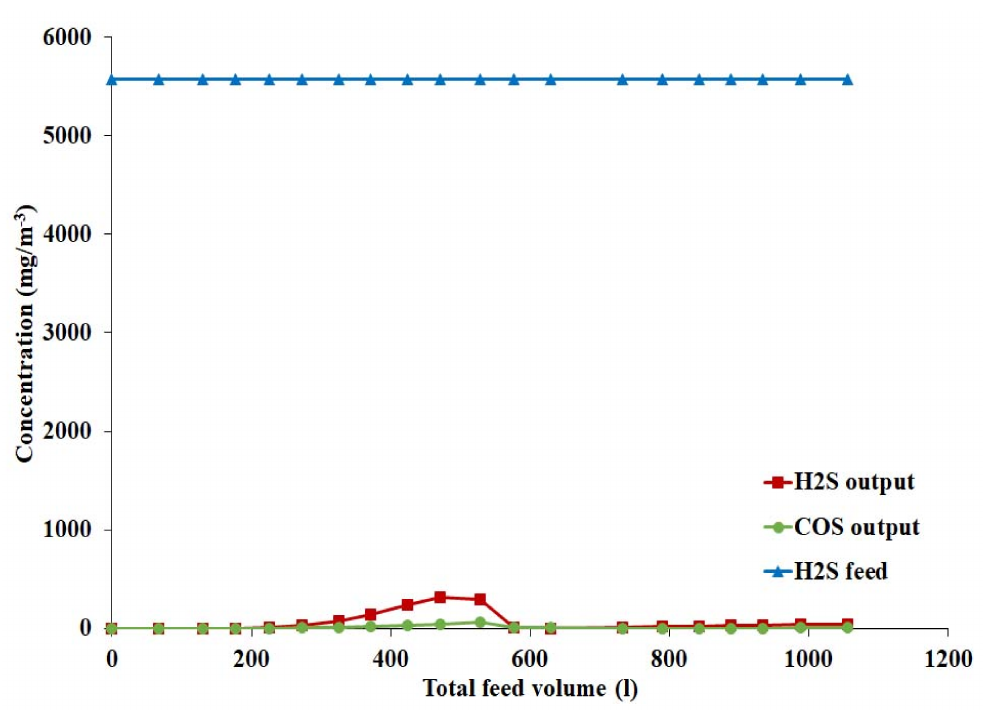
Figure 7. Catalytic tests with feed gas mixture 2 (50 mole% CO, 0.4 mole% H 2 S, balance N 2 ) at pressure 0.5 MPa over a Ni-based catalyst. H 2 S and COS content in the produced gas (output) compared to the H 2 S content in the feed gas.